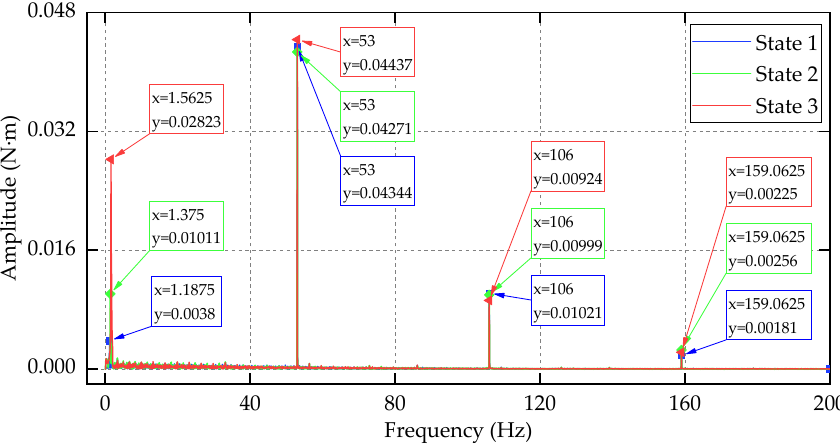
Figure 11. The frequency-domain curve of the disturbance torque in tests 1–3.